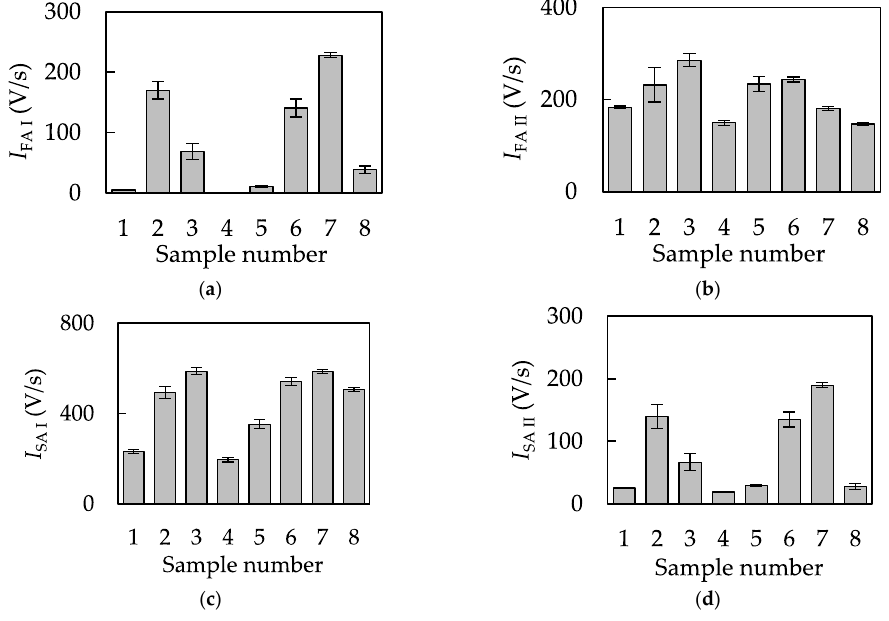
Figure 4. The intensity of firing of mechanoreceptive unit (m), I m . ( a ) I FA I ; ( b ) I FA II ; ( c ) I SA I ; and ( d ) I SA II (mean ± SD, n = 10).